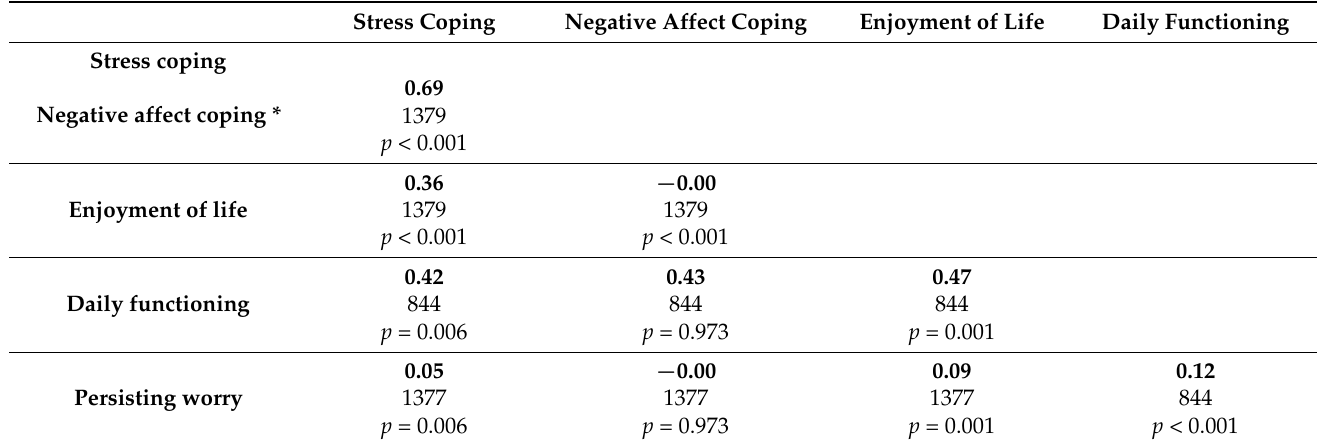
Table 2. Correlations among measures of perceived effects of